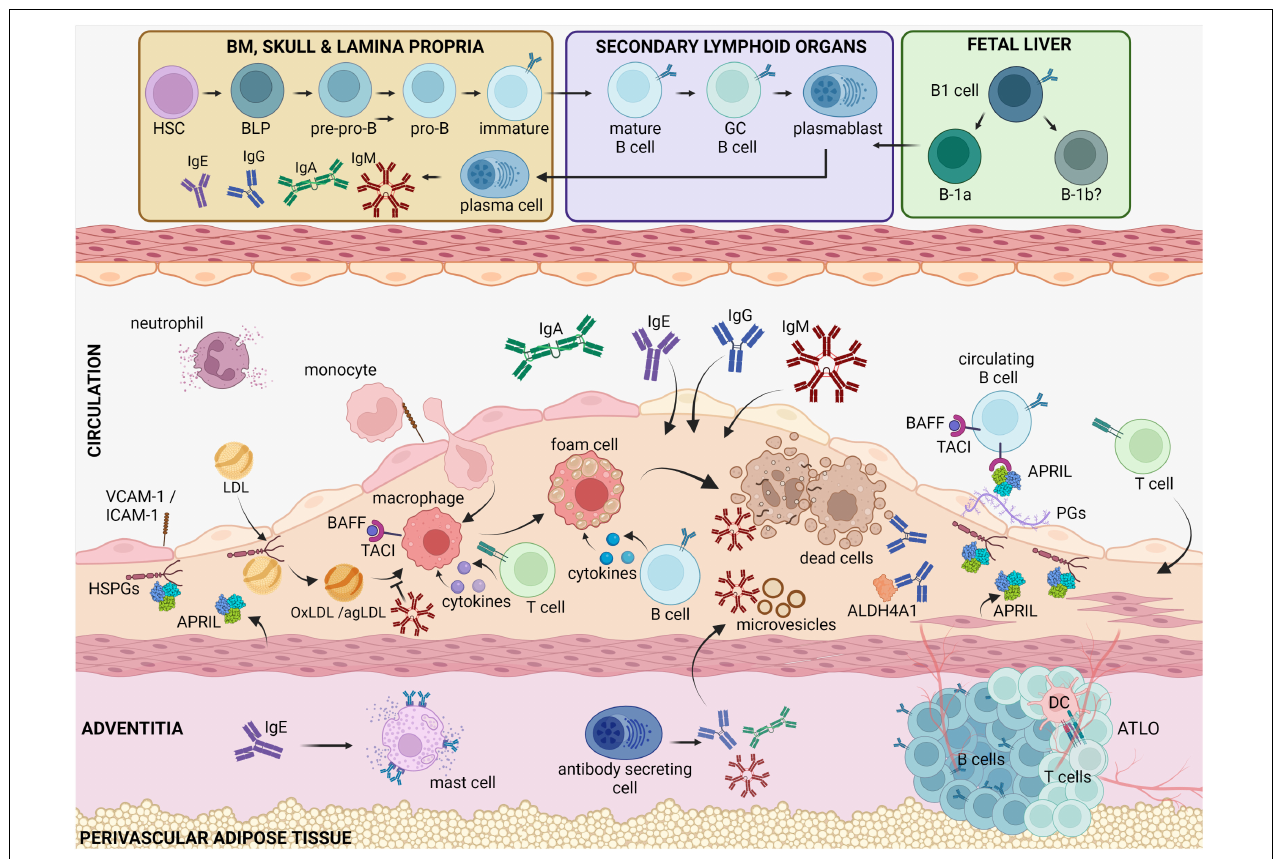
FIGURE 1 | B cell functions in atherosclerotic disease. Circulating cholesterol-containing LDL particles are progressively retained in the subendothelial space of arteries. Oxidized or aggregated LDL particles are taken up by arterial macrophages, which turn to foam cells because of uncontrolled lipid uptake and thereby undergo apoptosis or necrosis. Antibody-producing cells that reside in the bone marrow, the spleen and in the adventitia, produce high amounts of antibodies that are deposited in the plaque. IgM is known to bind and block the proinflammatory effects of oxidized LDL, apoptotic cells and microvesicles. IgE antibodies by binding to Fc ε RI receptors activate powerful proinflammatory responses by mast cells and macrophages. IgG antibodies can also bind OxLDL as well as self-proteins, such as ALDH4A1, and modulate macrophage activation. BAFF and APRIL, which both bind the TACI receptor in B cells, dampen the proinflammatory responses by macrophages, and limit the LDL retention in the intima, respectively, thereby revealing an indirect property of B cells to regulate plaque inflammation. BLPs, B-cell-biased lymphoid progenitors; PGs, proteoglycans, TACI, Transmembrane activator and CAML interactor; BAFF, B cell activating factor; APRIL, A